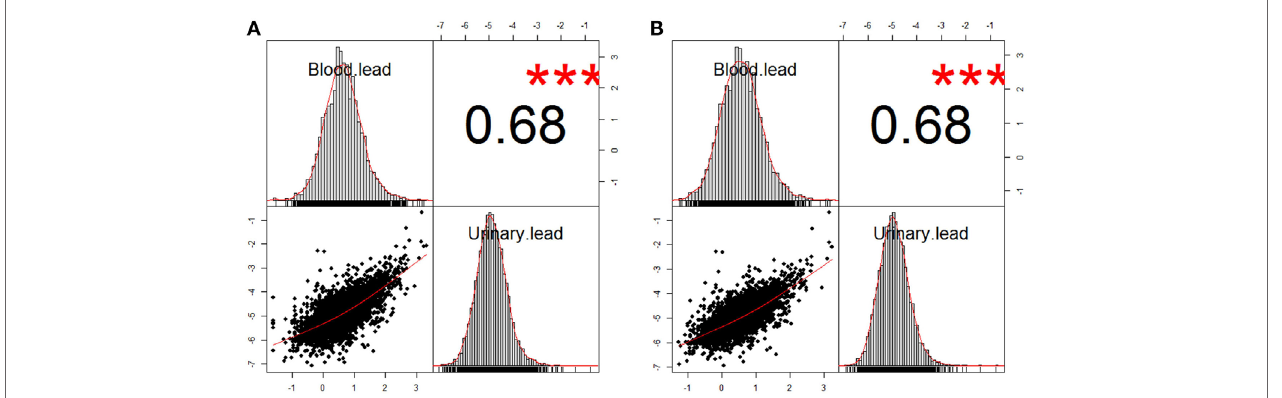
FigUre 1 | Correlation between blood lead and urinary lead in two analysis populations. (a) n = 5,193 after excluding participants with missing data of blood lead concentration from study population 1. (B) n = 3,677 after excluding participants with missing data of blood lead concentration from study population 2. The information about study population 1 and 2 can be found in Figure S1 in Supplementary Material. The correlation coefficients of both analysis populations were 0.68, and *** denotes P < 0.01.